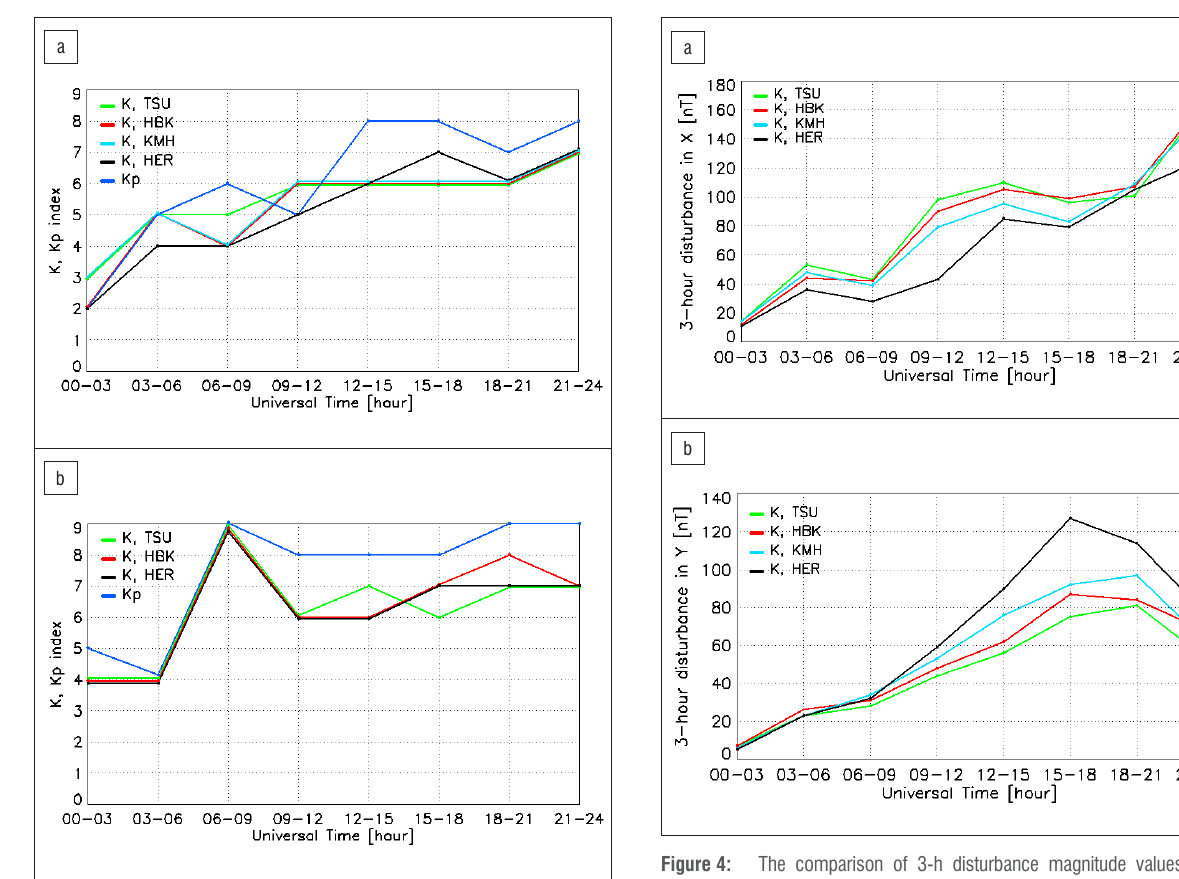
Figure 4: The comparison of 3-h disturbance magnitude values in the (a) X component and (b) Y component at HER, HBK, KMH and TSU on 17 March 2015. These disturbance values were calculated by subtracting the solar quiet-day variation (Sq) from recorded geomagnetic variations and determining the largest range of geomagnetic disturbances during a 3-h UT interval.